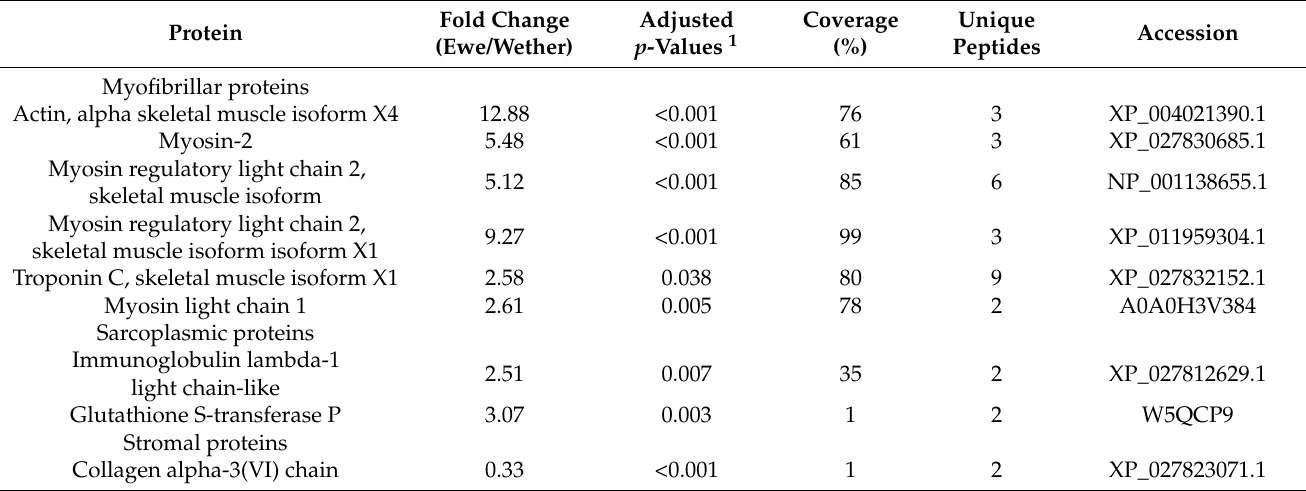
Table 3. Identified myofibrillar, sarcoplasmic, and stromal proteins that significantly differed between raw lamb longissimus lumborum muscle from 6- to 8-month-old ewe and wether lambs grazed on chicory. n = 6 for CHIC-W and n = 7 for